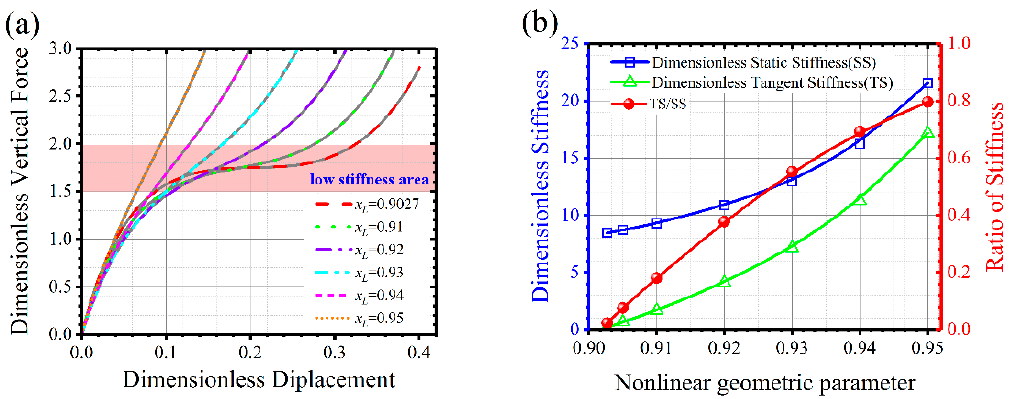
Figure 4. Dimensionless vertical force ( a ) and stiffness characteristic at the optimal working point ( b ) of the geometric anti-spring isolator.